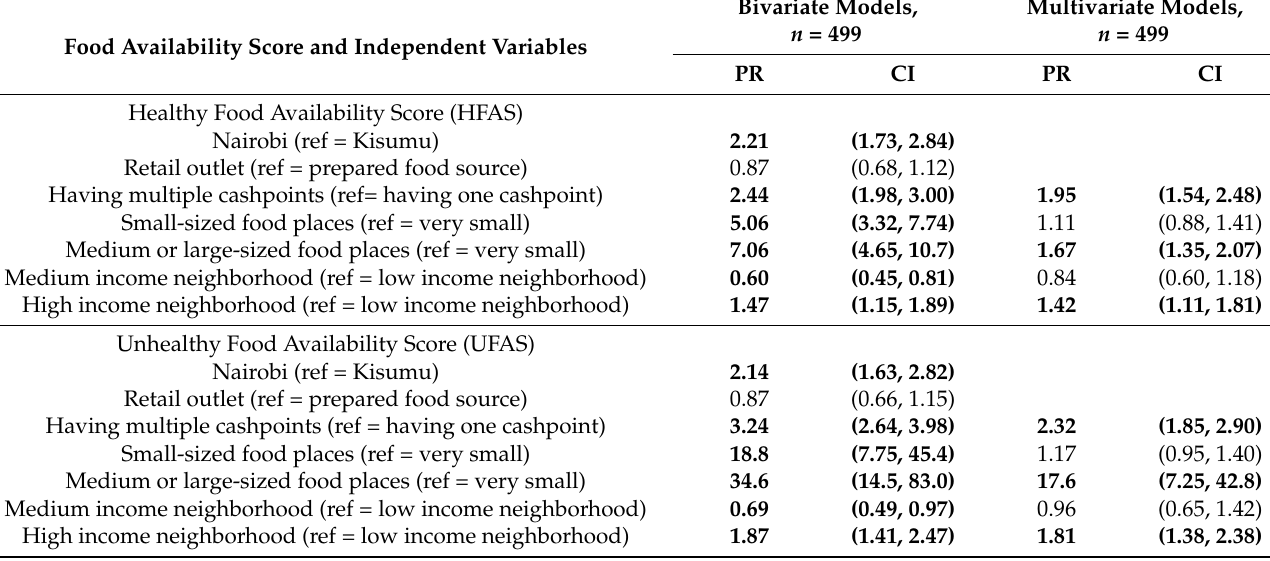
Bivariate Models, Multivariate Models, n = 499 n =